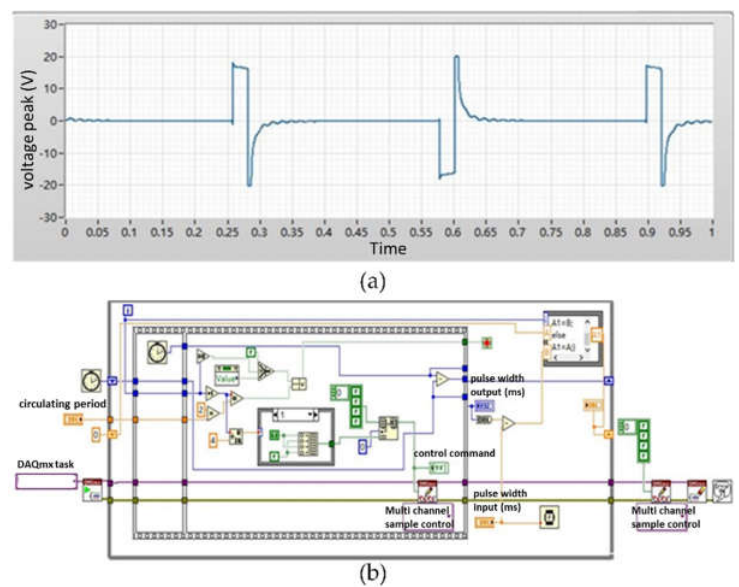
Figure 13. Three pulse signals from Hall sensors: (a) Schematic diagram of the signals; (b) Signal collection results.